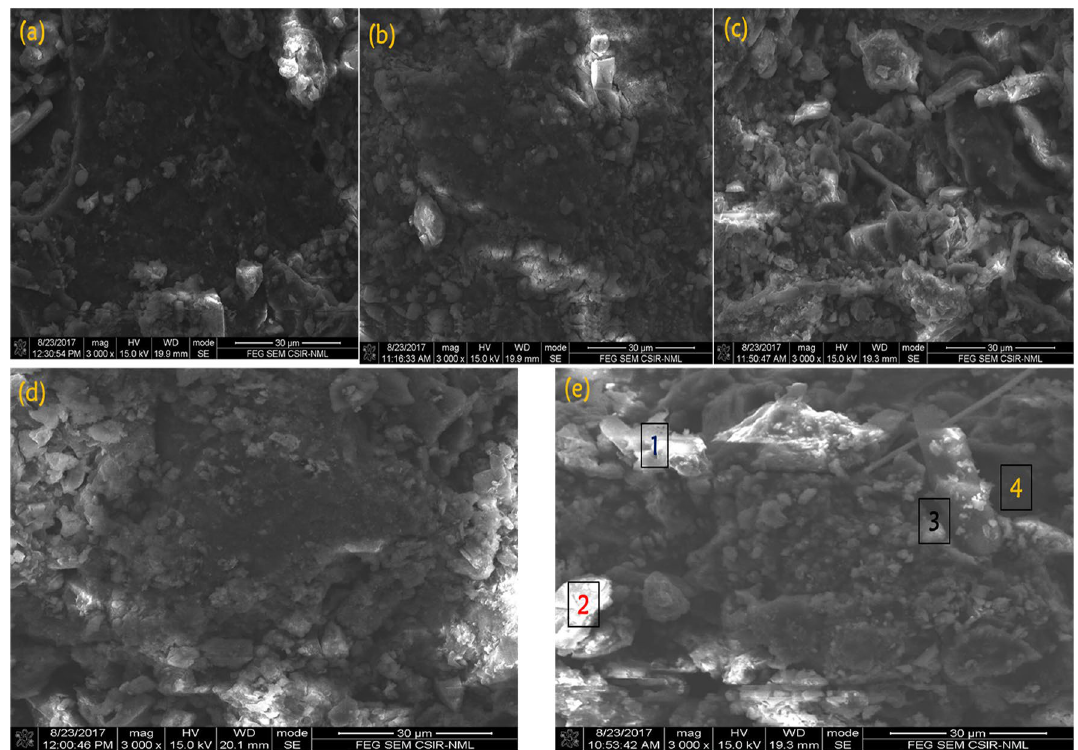
Figure 8. SEM images of the briquettes with varying bentonite contents ( a ) 2%, ( b ) 4%, ( c ) 6%, ( d ) 8%, ( e )